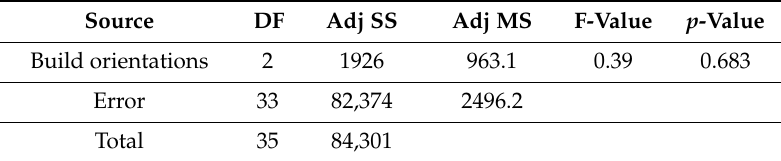
Table 12. ANOVA results for E as a function of build orientation.